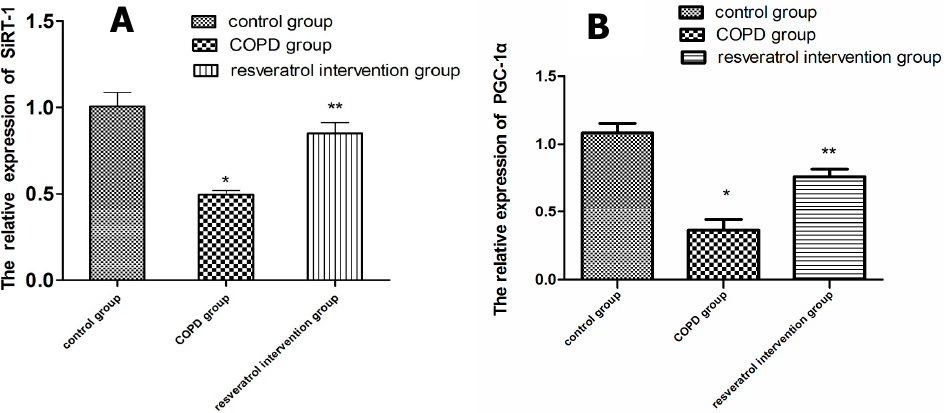
Figure 7. SIRT1 ( A ) and PGC-1 α ( B ) mRNA expression in the lung of rats from the control (n = 10), COPD (n = 10) and resveratrol groups (n = 10). SIRT1 and PGC-1 α mRNA expression measured by quantitative RT-PCR were decreased in lungs of COPD rats and increased by the resveratrol treatment. Resveratrol increased the expression of SIRT1 and PGC-1 α in the lungs of rats with COPD. * p < 0.01, vs. Control group; ** p < 0.01, vs. COPD group.